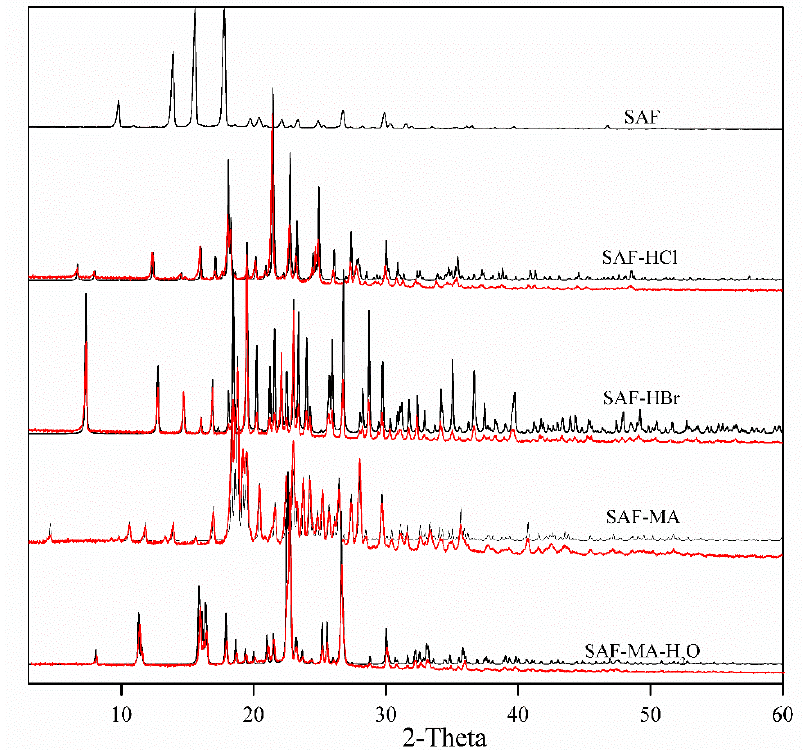
Figure 5. SAF cations, MA anions, and water molecules form a closely linked R 7 sheet structure.